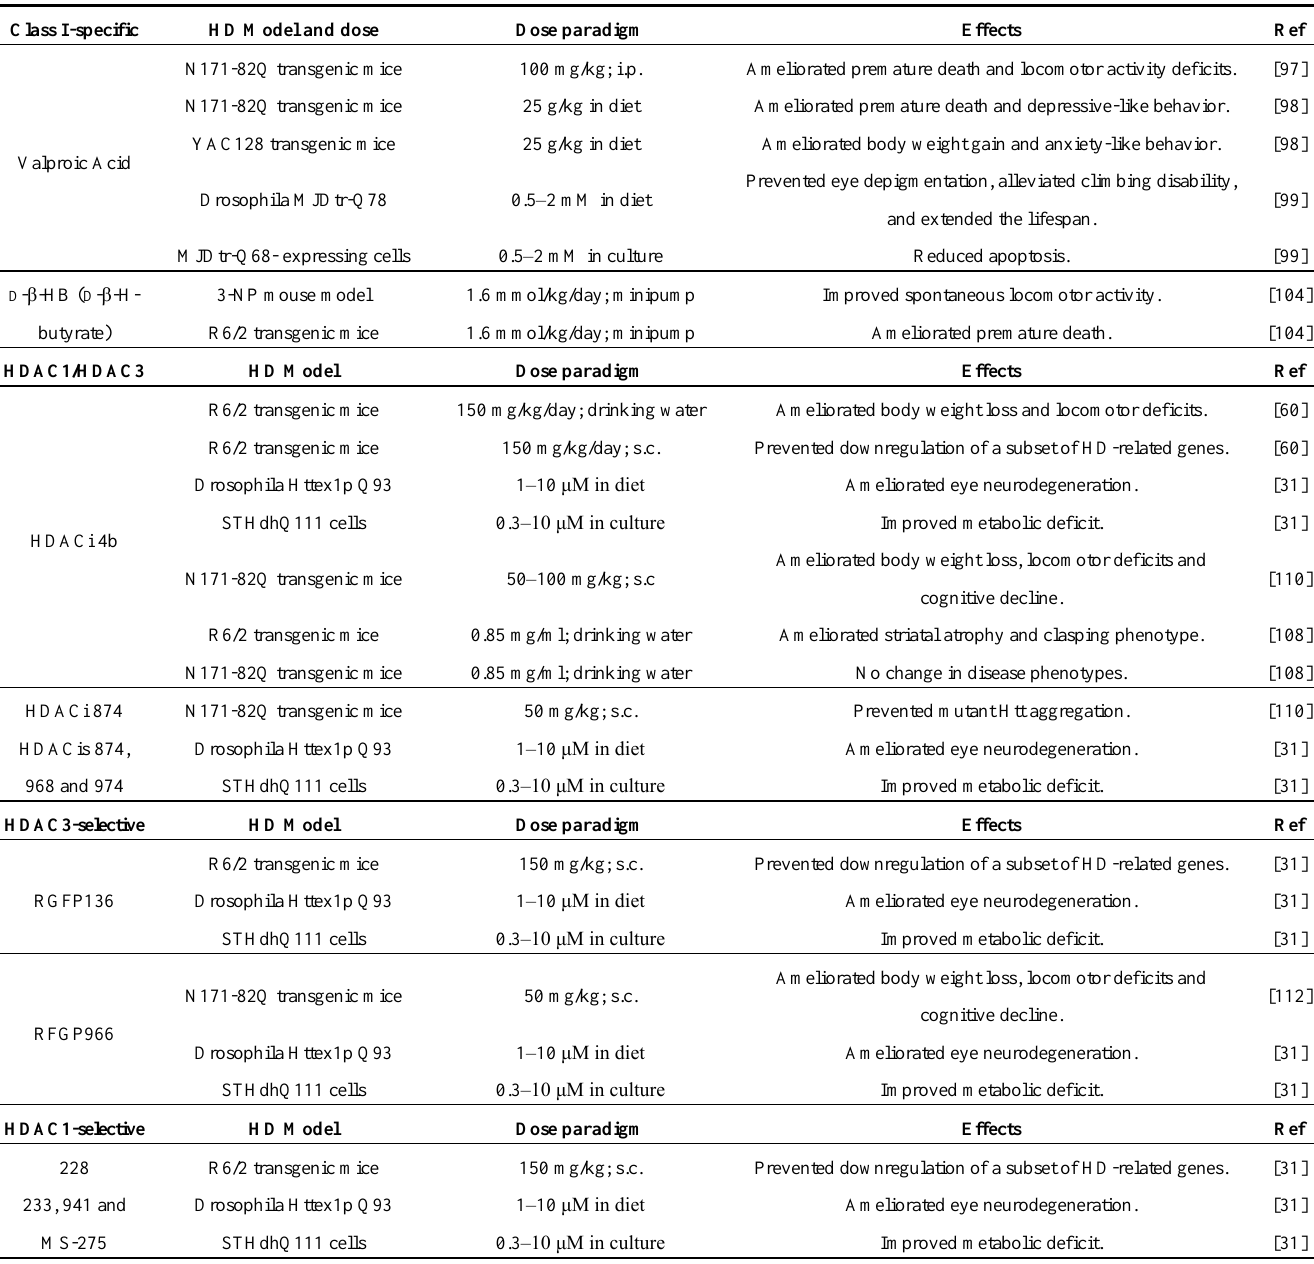
Table 1. Class I specific and isotype-selective HDAC inhibitors tested in HD model